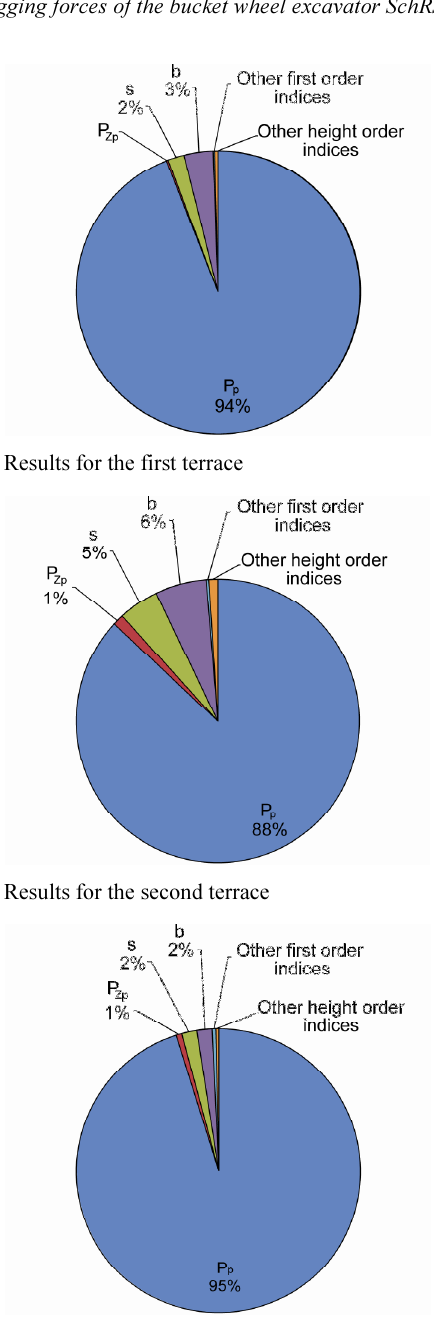
Fig. 15. Results for the third terrace